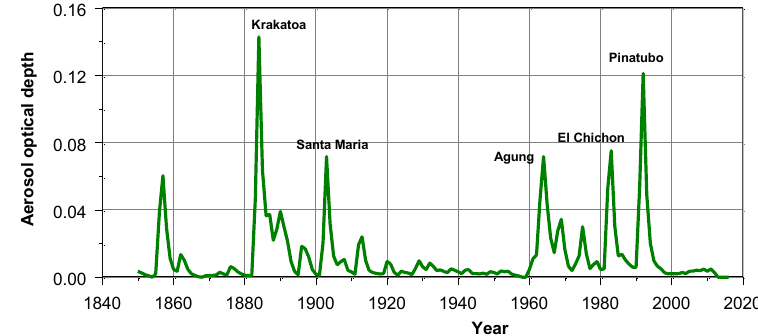
Figure 6. The AOD index series as introduced by Sato et al. (1993). Period is 1850–2016.